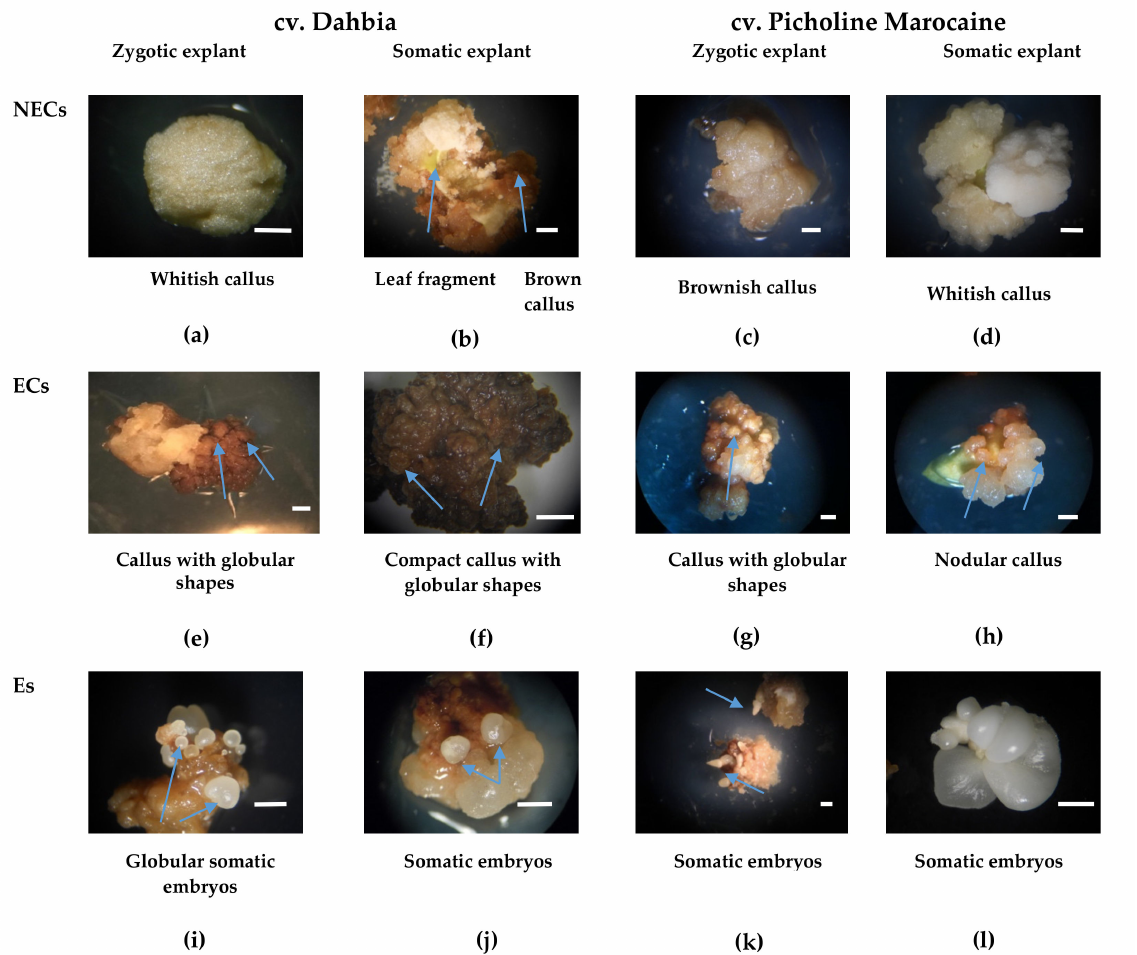
Figure 1. Morphological characteristics of the nonembryogenic calluses (NECs), embryogenic calluses (ECs), and somatic embryos (Es) obtained from the zygotic and somatic explants of two olive cvs. Dahbia and Picholine Marocaine, cultivated on expression medium after 4 weeks of culture in an induction medium for zygotic explants and 6 weeks for somatic explants, followed by 4 weeks of culture in a proliferation medium subculture from the induction to proliferation medium. ( a ) Spongy and white NECs obtained from zygotic explant of cv. Dahbia, ( b ) Brown NECs obtained from somatic explants of cv. Dahbia, ( c , d ) Friable NECs obtained from both zygotic and somatic explants of cv. Picholine Marocaine, ( e , f ) ECs of cv. Dahbia with abundant development of nodular structures, ( g , h ) Nodular structures developed on ECs of cv. Picholine Marocaine, ( i , j ) Globular somatic embryos observed on both, zygotic and somatic explants of cv. Dahbia, ( k , l ) Somatic embryos with different shapes obtained from cv. Picholine Marocaine. The bars correspond to 1 mm. The arrows on the ECs and Es indicate structures with a nodular appearance and Es,